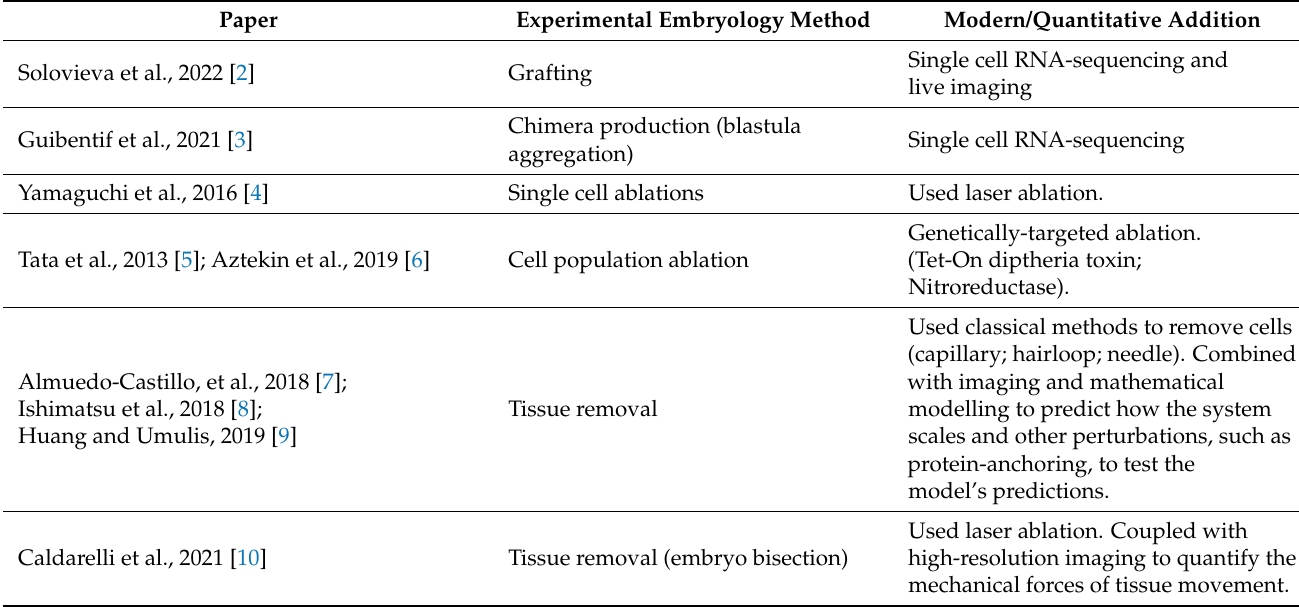
Table 2. Examples of modern quantitative adaptations of experimental embryology